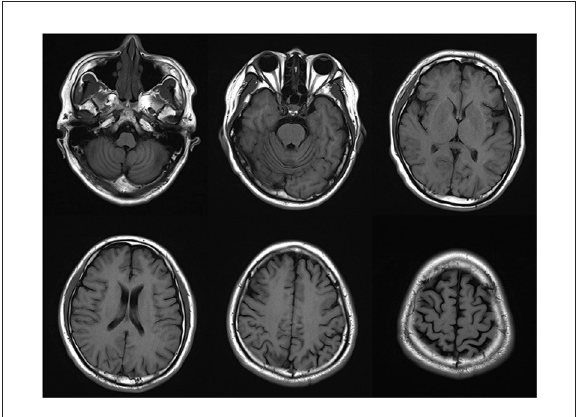
FIGURE1 Brain MRI showed atrophy of the cerebrum and cerebellum.